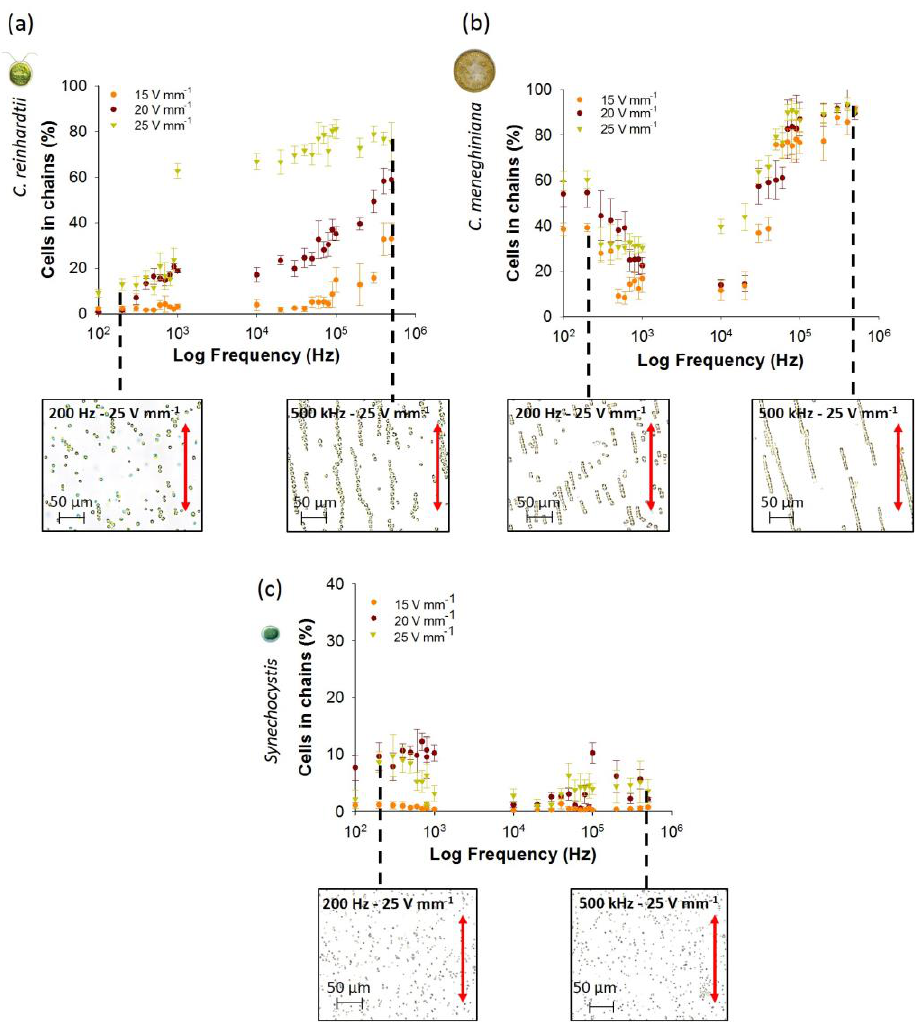
Figure 1. Effect of AC field intensity and low frequency on the chaining efficiency obtained with the coplanar electrode after 5 min of electric field application for: ( a ) C. reinhardtii ; ( b ) C. meneghiniana ; ( c ) Synechocystis sp. Micrographs illustrate the chaining pattern, parallel to the electric field direction given by the red arrow, for each phytoplankton species at 200 Hz and 500 kHz, field intensity of 25 V · mm − 1 . Initial concentration of phytoplankton species: 5 × 10 6 cells · mL − 1 C. reinhardtii and C. meneghiniana ; 5 × 10 7 cells · mL − 1 Synechocystis sp.